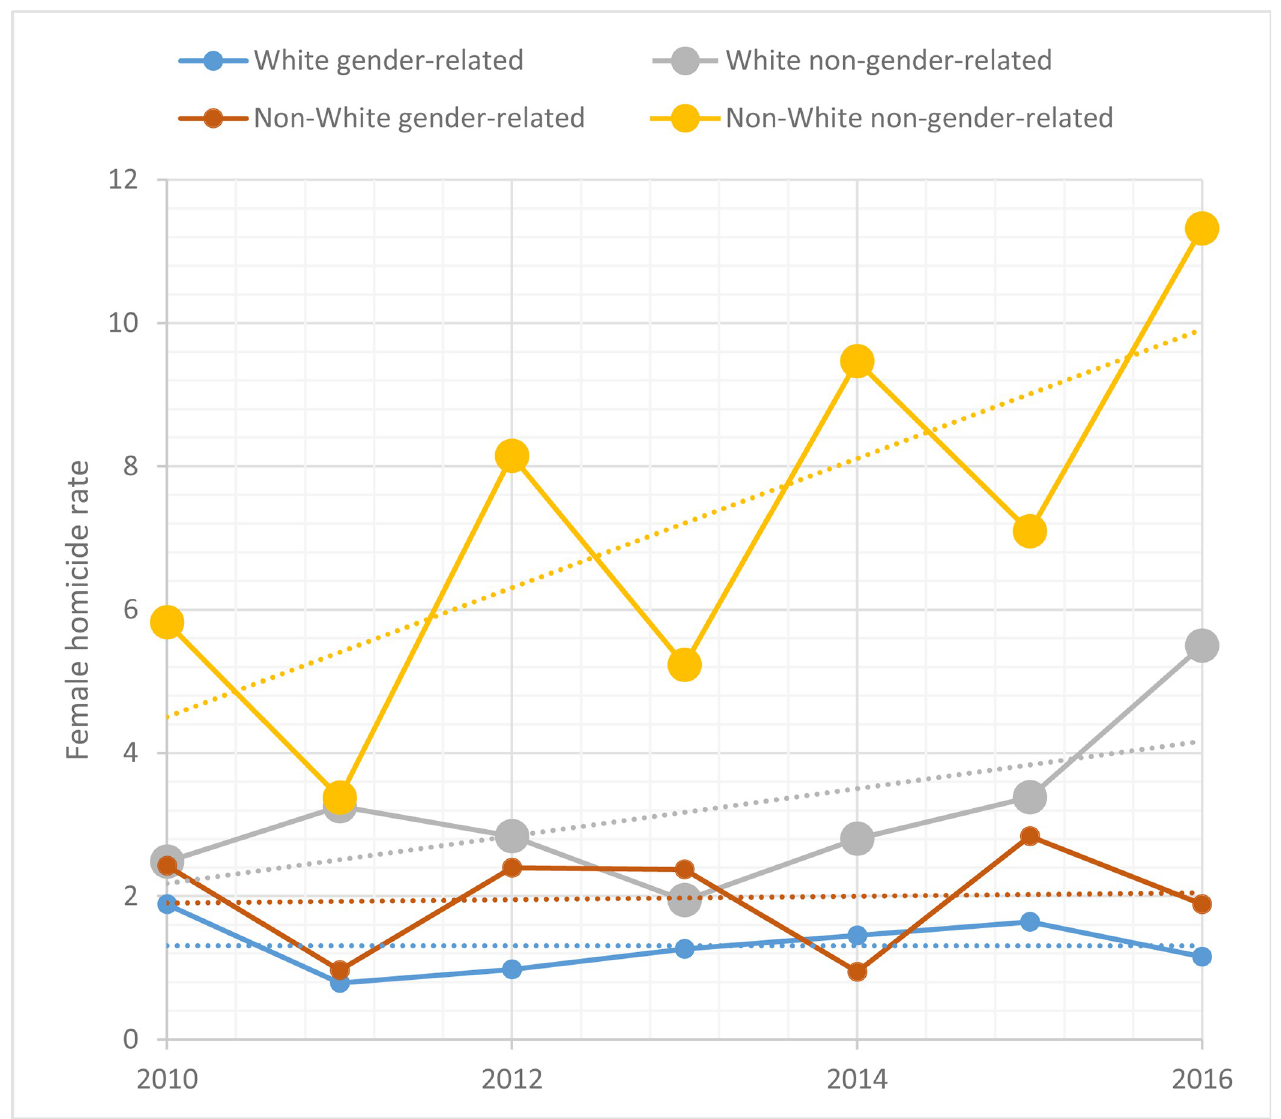
Fig 2. Female homicide rate in Porto Alegre between 2010–2016 according to motivation and skin